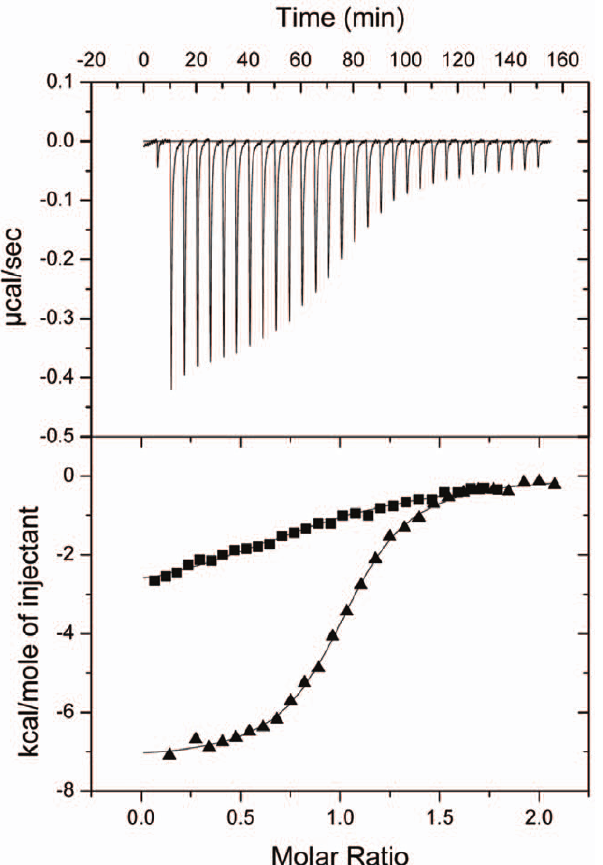
Figure 3. Characterisation of the interaction between NOXO1 SH3 AB–E and p22 phox . Upper part shows the raw calorimetric data for the interaction of mouse p22 phox C- NOXO1 SH3 AB–E . Lower part shows the integrated heat changes, corrected for heat of dilution, and fitted to a single site binding model. ( & ) Human p22 phox C titrated into human Figure 2. Characterisation of the interaction between the